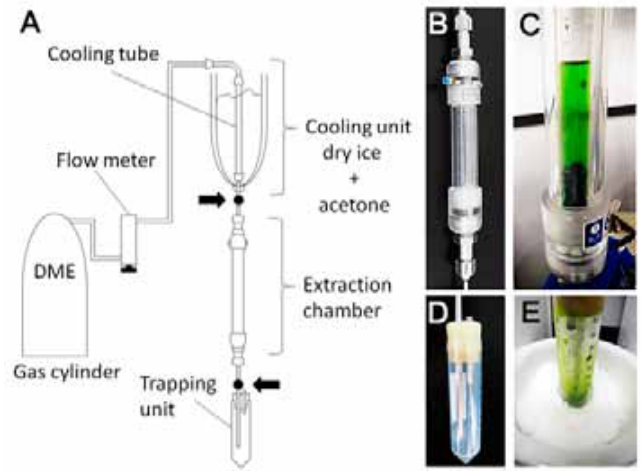
Fig. 1 - Apparatus for pigment extraction with liquefied DME. (A) Composition of the system. Arrows indicate the positions of two stopcocks designed for fine controls of gaseous and lique- fied DME flows. (B, C) Extraction chamber. (D, E) Trapping port with a plastic